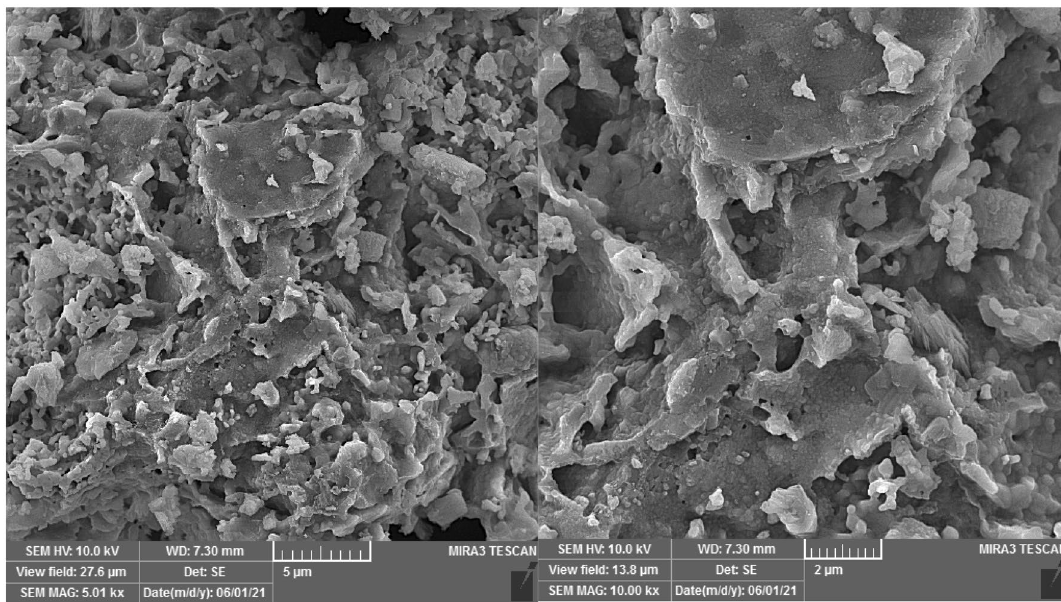
Figure 1. FESEM of PG adsorbent with two